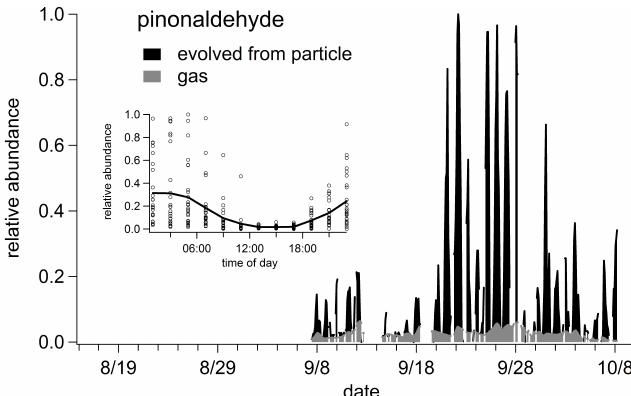
Fig. 7. Time series plot of the fraction of pinonaldehyde in the gas and particle phases, according to TAG measurements, for the en- tire campaign showing that the observation of pinonaldehyde was not the result of a gas phase collection artifact. The diurnal varia- tion of pinonaldehyde for the entire campaign (inset) showing the predominance of higher abundances at